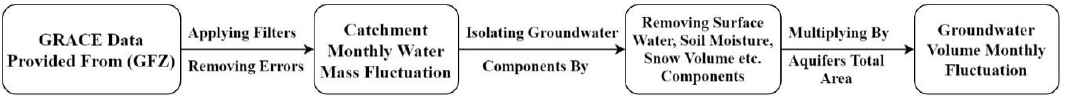
Figure 3. Flow chart showing the usages of Gravity Recovery and Climate Experiment (GRACE) data to assess groundwater volume fluctuation. GFZ, German Research Center for Geosciences.